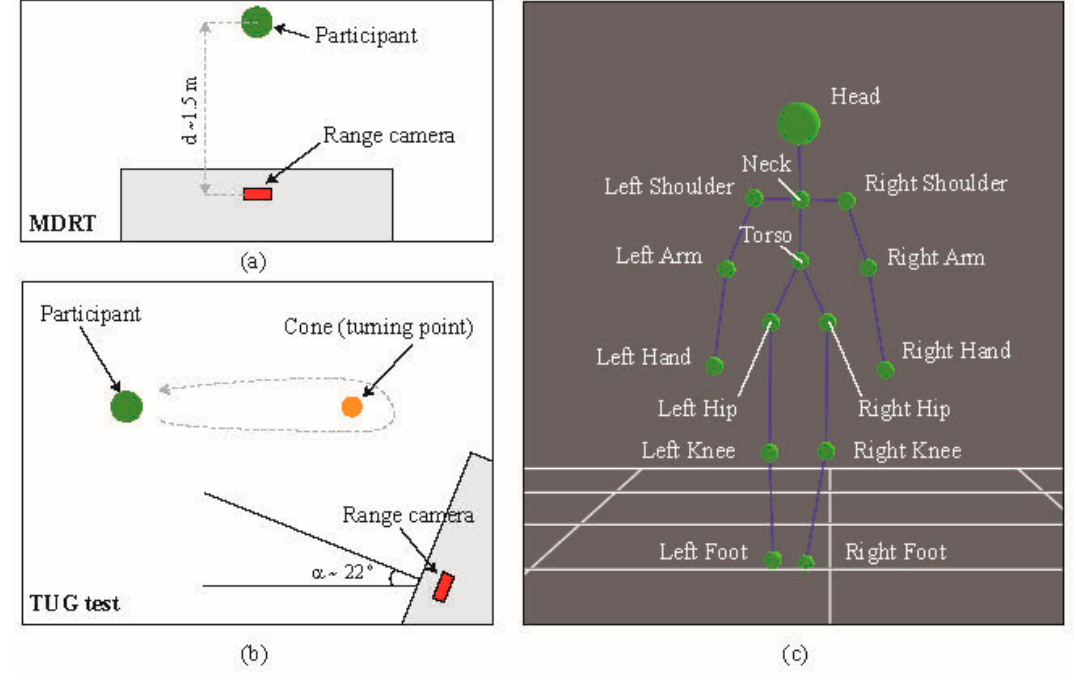
Figure 2. Experiment setup for the ( a ) MDRTs and the ( b ) TUG test. ( c ) Joints detected with the depth camera.